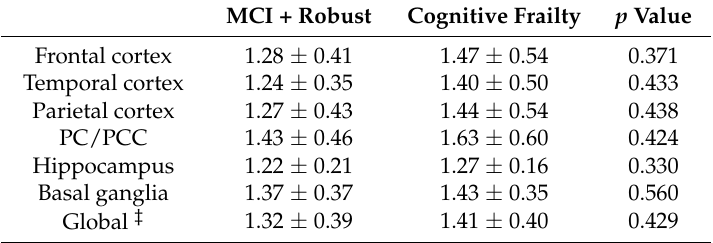
Table 2. Comparison of standard uptake value ratios (SUVRs) for 11C-Pittsburgh compound B ( 11 C-PiB) in MCI and cognitive frailty subjects.